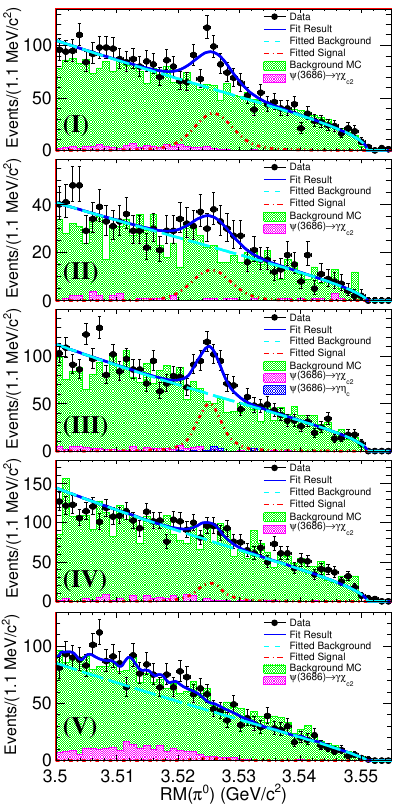
Figure 4. Recoiling mass spectra of the lowest energy π 0 , in the decay chains ψ (2 S ) → π 0 h c with h c → p ¯ p π + π − (I), π + π − π 0 (II), 2( π + π − ) π 0 (III), 3( π + π − ) π 0 (IV), and K + K − π + π −